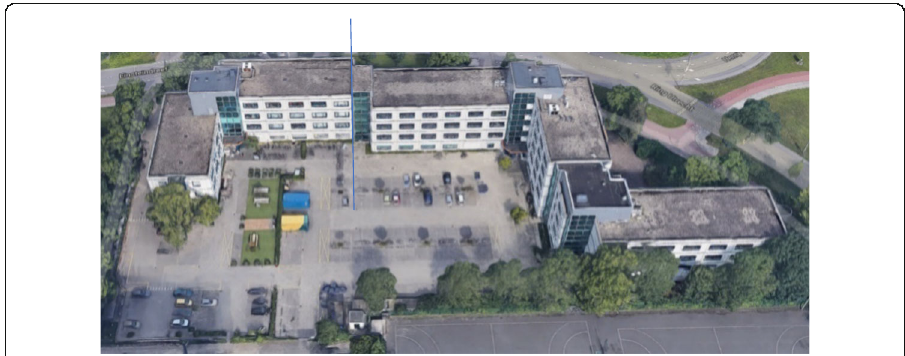
Fig. 2 Plan Einstein in Overvecht (from Google Earth